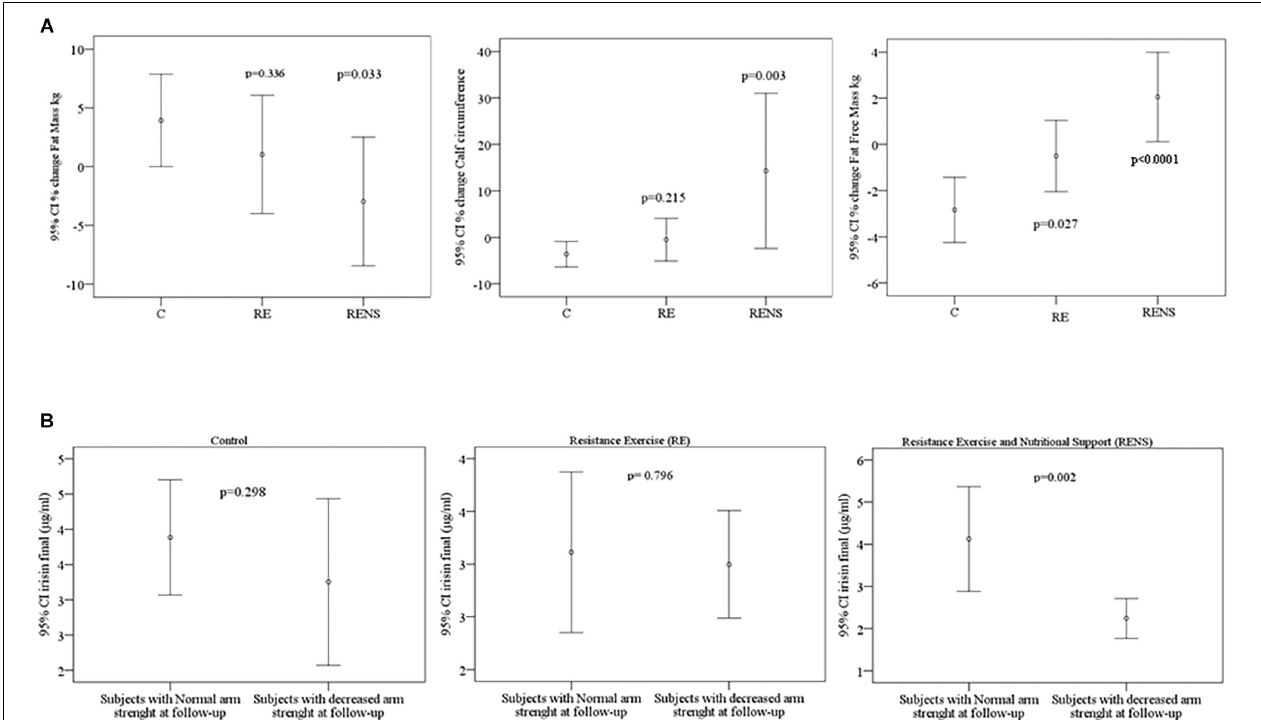
FIGURE 1 | (A) Comparison of percent change of fat free mass, calf circumference and fat mass according to control (C), resistance exercise (RE), and resistance exercise plus nutritional support (RENS). (B) Comparison of circulating irisin according to arm strength in C, RE, and RENS groups.